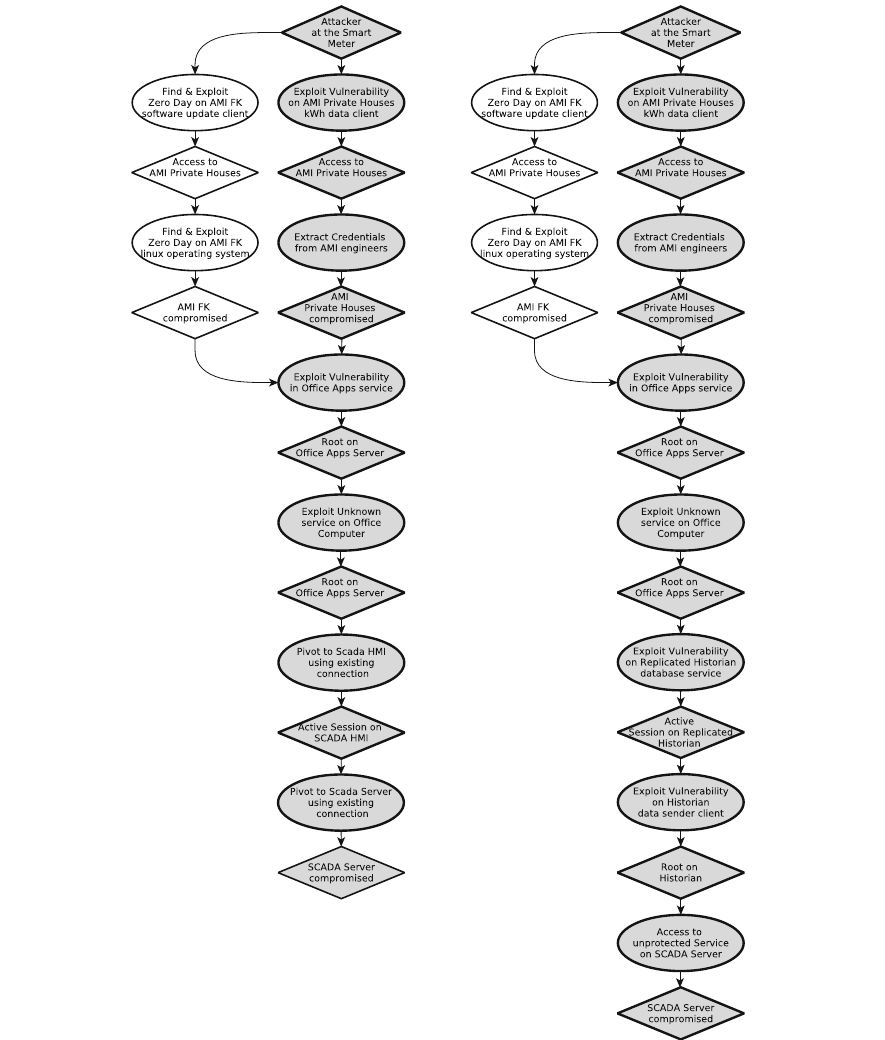
Fig. 9 Aggregated attack graph of an attacker positioned at a smart